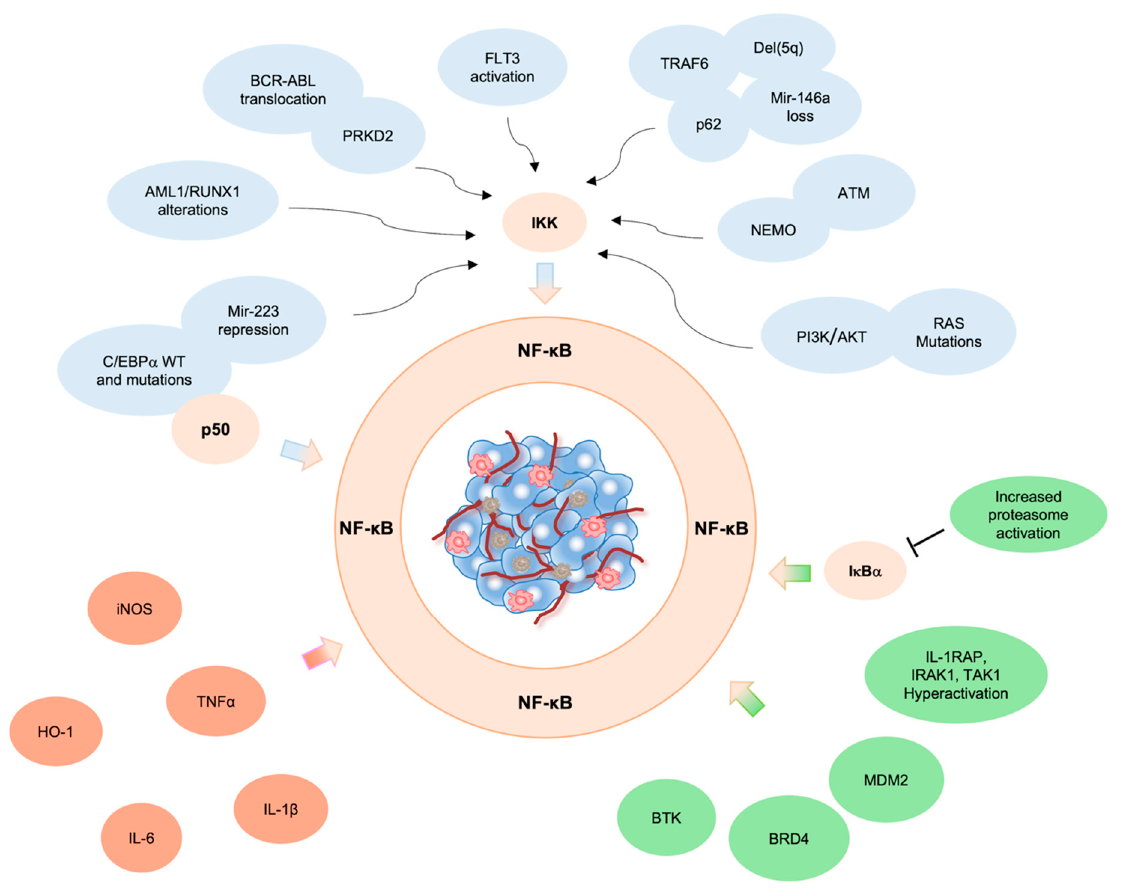
Figure 1. NF- κ B activity in AML. Constitutive activation of NF- κ B in AML triggered by ( i ) genetic alterations (blue), ( ii ) pro-inflammatory cytokines in the TME (fuchsia) and/or ( iii ) increased expression of NF- κ B signaling components (green).